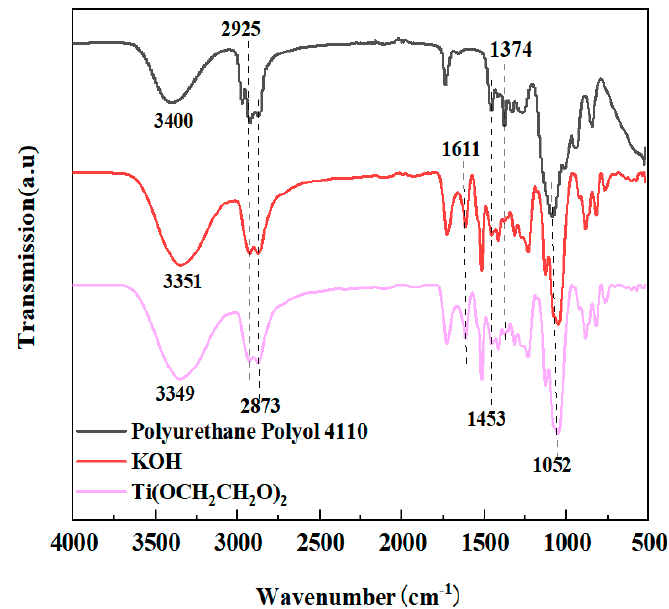
Figure 9. IR spectra of recycled polyol and polyether polyol 4110 recovered from different